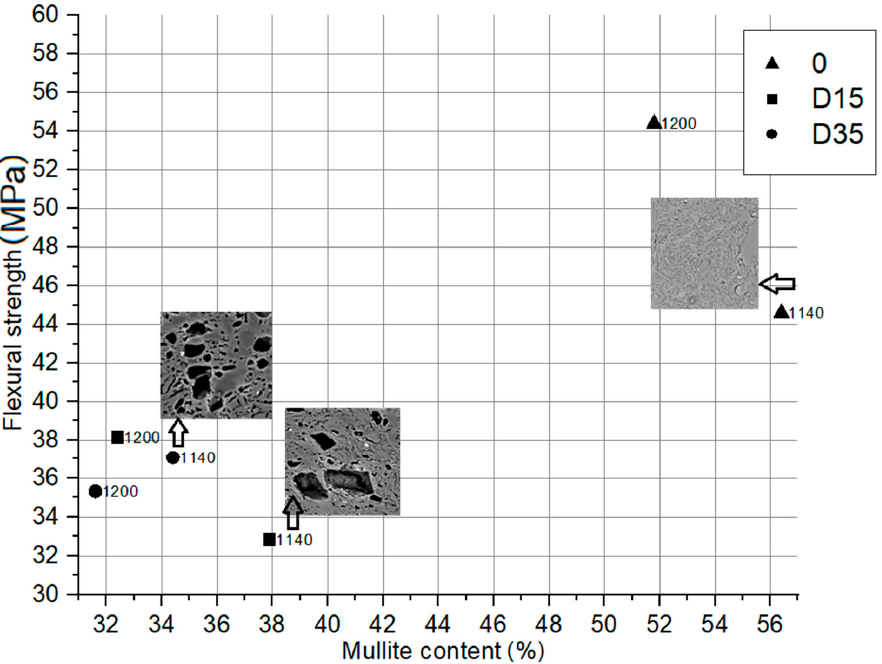
Figure 10. Dependence between flexural strength of obtained ceramic materials and mullite content in their phase composition.